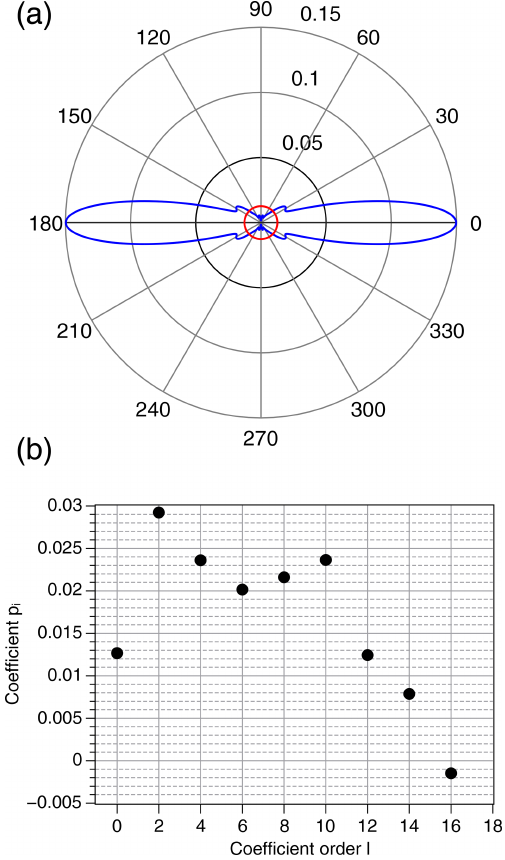
Figure 5. (a) Polar plot (in blue) of the orientation probability den- sity P ( β ) for cuprorivaite magnetically oriented in fluid oil. The red circle represents a perfectly isotropic orientation distribution P ( β ) = 1 / 8 π 2 . (b) Coefficients p l in the expansion of P ( β ) ac- cording to Eq. (6). Odd-order coefficients are all